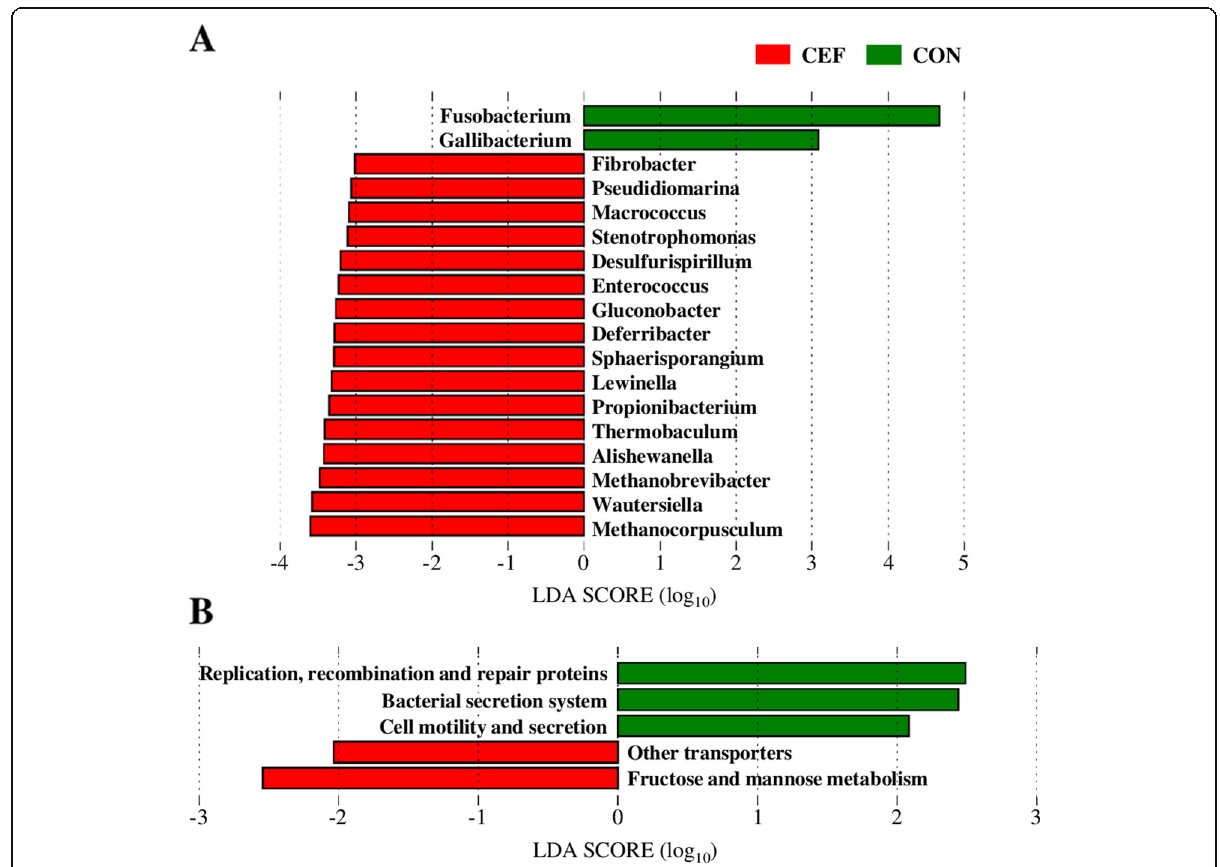
Fig. 4 The linear discriminant analysis effect size (LEfSe) method to identify differential features between CEF and CON on 7 ± 1 DPP. a Taxonomic profiles with LDA score higher than 3. b Metabolic profiles with LDA score higher than 2